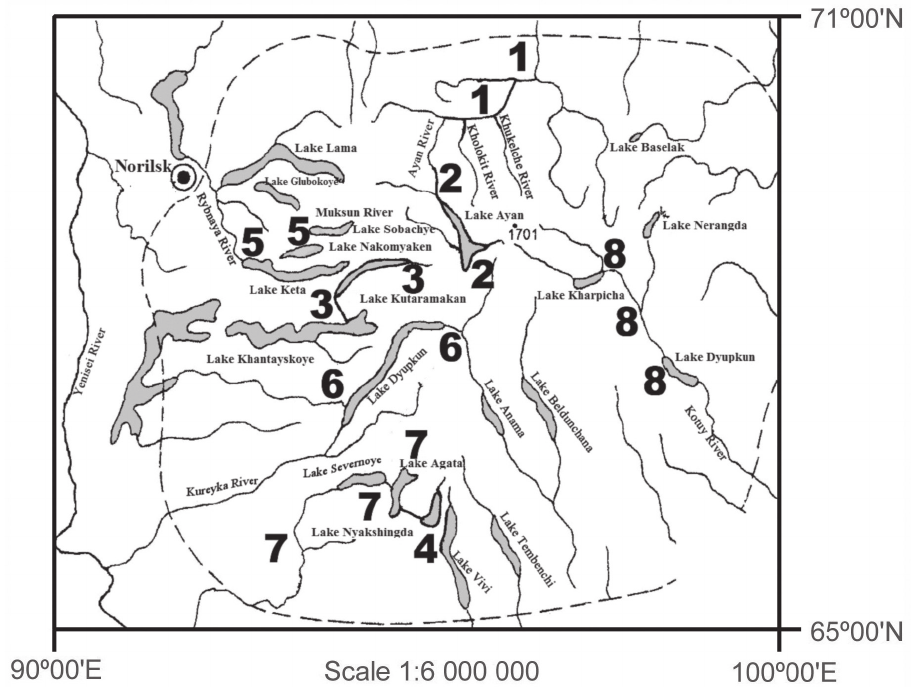
Figure 1. Areas and years of ornithological research on the Putorana Plateau: 1 Northern regions (Lake Bokovoye; rivers: Ayan, Ambar, Munil, Nerakachi, Dakit, Kholokit, Khukelche), 1989 2 Central regions (Lake Ayan, Lake Kapchug; rivers: Amnundakta, Gulyami, Bolshoy Khonna-Makit, Kapchug), 1988 3 Western regions (lakes: Kutaramakan, Kapchuk, Khantayskoye; rivers: Verkhniy Kutaramakan, Kuta- ramakan, Kapchuk, Bogadil, Irkinda), 1990 4 Southern regions (Lake Nyakshingda, Lake Vivi; rivers: Amundykan, Verkhnyaya Nyakshingda, Nyakshingda, Irbukon, Morktakon, Sengan), 1991 5 Western regions (lakes: Keta, Nakomyaken, Sobachye, Glubokoye; rivers: Nahta, Mikchangda, Muksun), 1999, 2004, 2008 6 South-west (Lake Dyupkun Kureiskiy; rivers: Kureyka, Yagtali), 2001, 2006 7 South-west- ern regions (lakes: Agata Verkhnyaya, Agata Nizhnyaya, Severnoye; rivers: Oron, Epekli-Sen, Severnaya), 2003 8 Eastern regions (lakes: Kharpicha, Dyupkun Kotuiskiy, Lyuksina; Kotuy River), 2007. Traditional border of Putorana